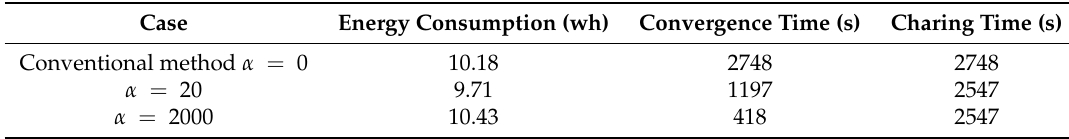
Table 1. Energy consumption of shunt